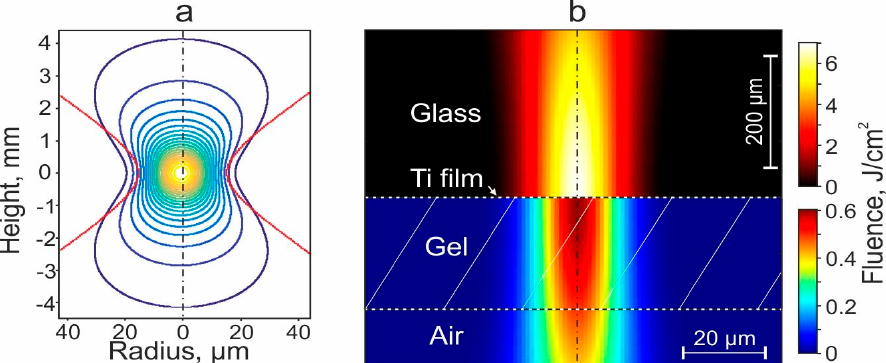
Figure 6. Distributions of laser intensity and fluence. ( a )—Distribution of the laser intensity in the focusing region in the absence of a donor plate. ( b )—Distribution of laser fluence during laser pulse action on a donor plate with Ti film and gel layer. For distributions in glass (above the Ti film) and in the gel layer their color palettes are shown.